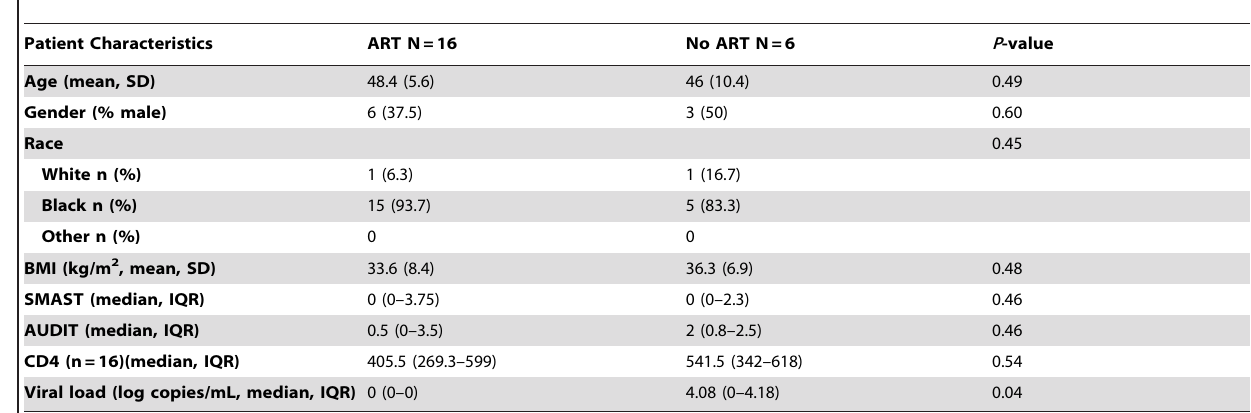
Table 2. Demographic characteristics of HIV-infected Subjects Enrolled in the Study.